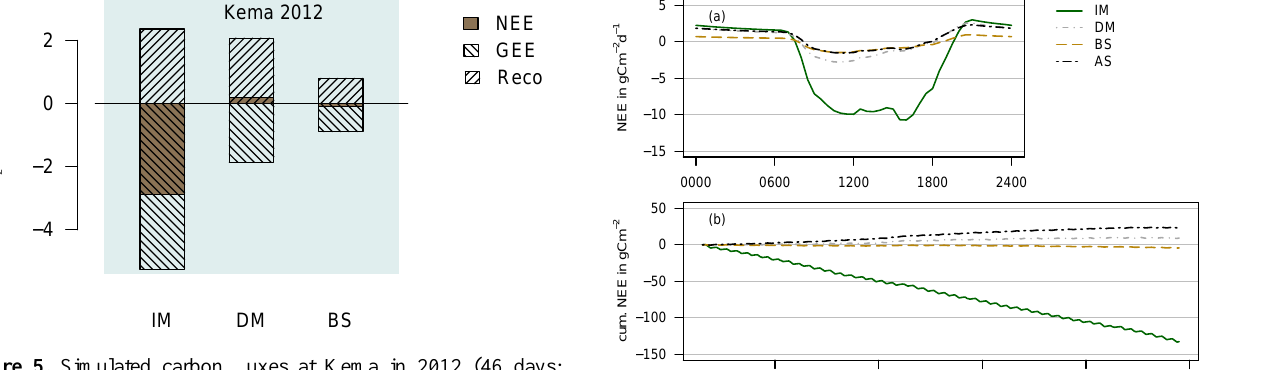
Figure 5. Simulated carbon fluxes at Kema in 2012 (46 days: 12 July to 26 August 2012) for IM, DM, and BS. Hatched bars denote the simulated GEE and R eco , the sum is the NEE (brown bar).